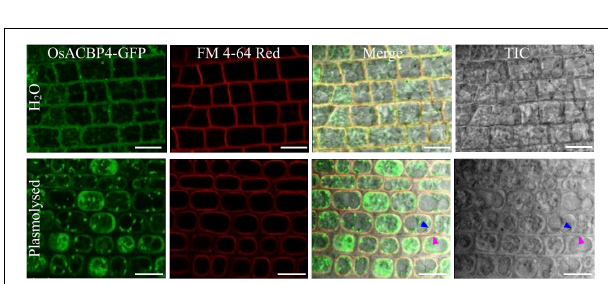
FIGURE 3 | Subcellular localization of OsACBP4:GFP in transgenic rice after plasmolysis. Root cells of 4-day-old transgenic rice seedlings were imaged by confocal laser scanning microscopy. Colocalization of OsACBP4:GFP (green) with FM 4–64 Red (red) (T13320, Invitrogen) in root cells of 4-day-old transgenic rice seedlings. Blue arrow indicates the plasma membrane and pink arrow shows the cell wall. Signals were colocalized at the plasma membrane but not the cell wall. Bars = 20 µ m. ACBP, acyl-CoA-binding protein; Os, Oryza sativa . Representative images were shown after observation with consistent results from at least 20 cells.